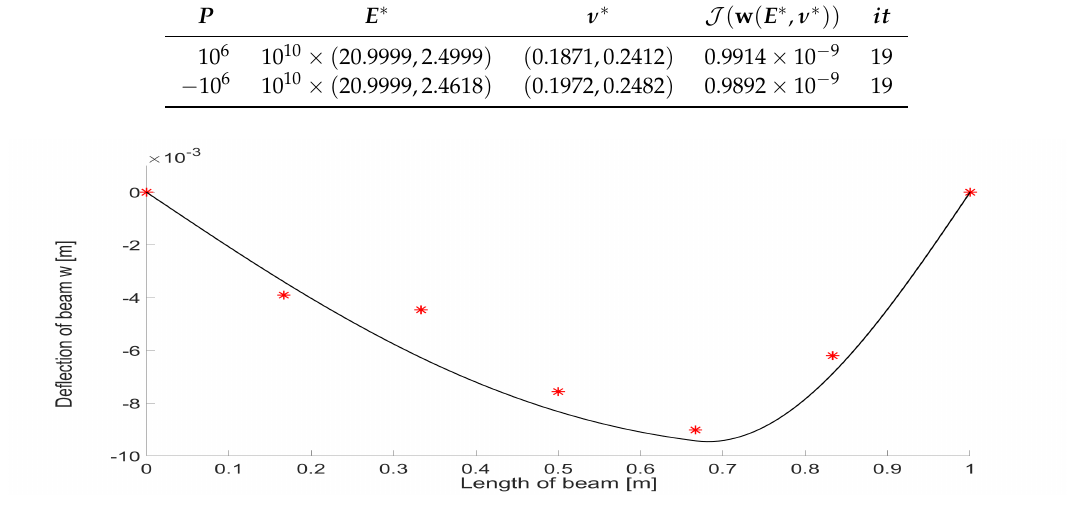
Figure 2. Deflection of the Gao beam for P = 10 6 N, q = − 4 × 10 6 Nm − 1 and ( E ∗ , ν ∗ ) . The asterisks stand for corresponding measured data z given in